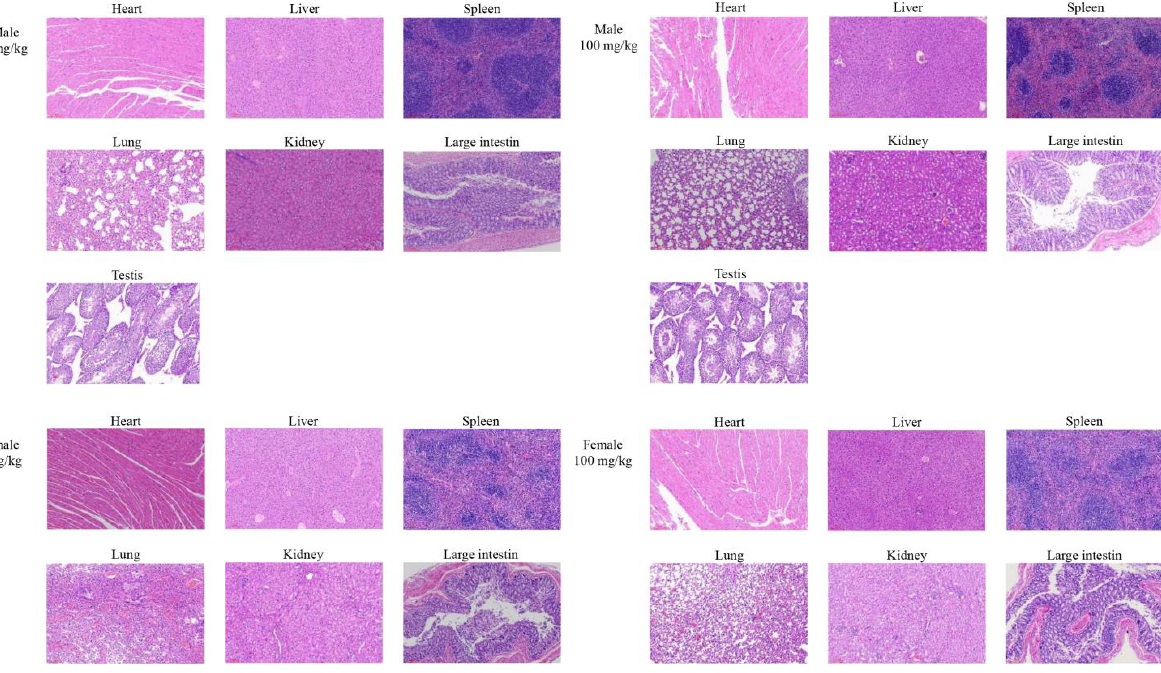
Figure 9. Histological examination. The male and female mice were fed with a fixed dose of 0 mg/kg BW and 100 mg/kg BW of cMORP for the repeated-dose 30-day oral toxicity study ( × 100). Table 6. Organ weights relative to body weight in the repeated-dose 30-day oral toxicity study. Organs 0 mg/kg 25 mg/kg 50 mg/kg 100 mg/kg Male Heart (%) 0.46 ± 0.05 0.49 ± 0.06 0.48 ± 0.05 0.48 ± 0.05 Liver (%)) 4.37 ± 0.15 4.36 ± 0.26 4.34 ± 0.30 4.18 ± 0.32 Spleen (%) 0.30 ± 0.05 0.28 ± 0.06 0.32 ± 0.10 0.26 ± 0.07 Lung (%) 0.49 ± 0.07 0.51 ± 0.07 0.51 ± 0.03 0.49 ± 0.08 Kidneys (%) 1.33 ± 0.08 1.28 ± 0.06 1.27 ± 0.10 1.35 ± 0.12 Testes (%) 0.55 ± 0.07 0.54 ± 0.06 0.55 ± 0.08 0.56 ± 0.04 Female Heart (%) 0.42 ± 0.03 0.43 ± 0.05 0.43 ± 0.04 0.44 ± 0.05 Liver (%)) 4.03 ± 0.64 4.33 ± 0.54 4.34 ± 0.52 4.10 ± 0.33 Spleen (%) 0.32 ± 0.09 0.34 ± 0.15 0.31 ± 0.07 0.31 ± 0.06 Lung (%) 0.62 ± 0.19 0.57 ± 0.14 0.62 ± 0.12 0.60 ± 0.09 Kidneys (%) 1.00 ± 0.11 1.03 ± 0.06 0.97 ± 0.08 0.99 ± 0.14 Units are given in brackets. Data are represented as mean ± SD ( n = 10). ND means not detected. * p < 0.05, versus the control group. White blood cells (WBCs) consisted of neutrophils, eosinophils, basophils, lympho- cytes, and monocytes, protecting the body from allergies, infections, and diseases by me- diating the immune system. It played an important role in the healing of body damage, the resistance to invasion of pathogens, and in the mediating of immune systems. The study of hematological parameters can provide a basis for assessment of inflammatory conditions, infectious assessment, and potential damage of the test substance [38]. The hematological parameters are summarized in Table 7, suggesting there was no significant difference in the hematological parameters between the control and test groups ( p > 0.05). The individual values of hematological parameters in groups were within normal